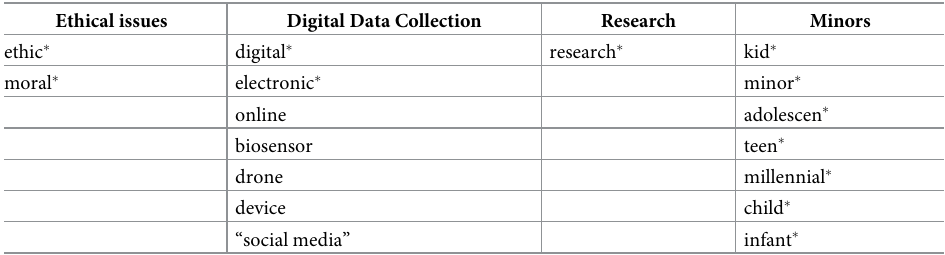
Table 1. Keywords for the academic literature